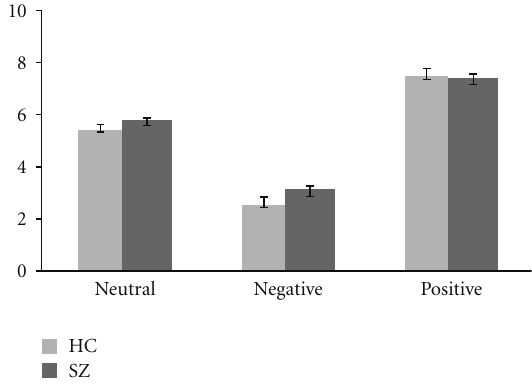
Figure 1: Ratings of adjectives previously categorized as “neutral,” “positive,” and “negative” by healthy controls and schizophrenic